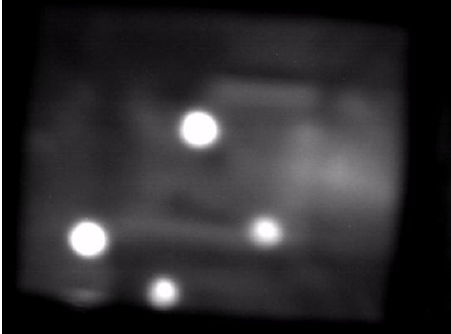
Figure 5. Example of the captured image from the proposed sensing